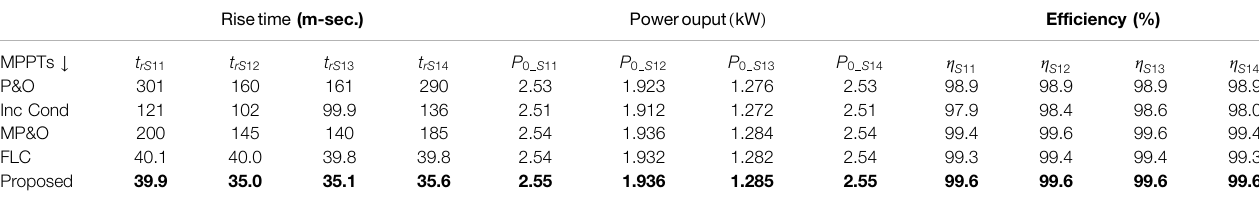
TABLE 3 | Performance comparison analysis of simulation results validated under scenario-I. Risetime (m-sec.)